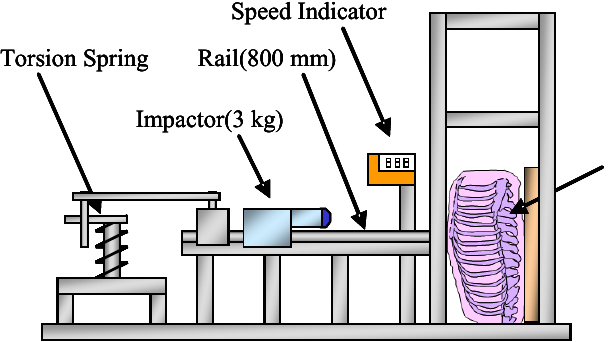
Fig. 1 Schematic diagram of the impact experimental setup. The thorax specimen was fixed in the rear of the crash plane with a board. The impactor, including the load cell, was launched toward the specimen using the energy of the torsion spring and slider-crank